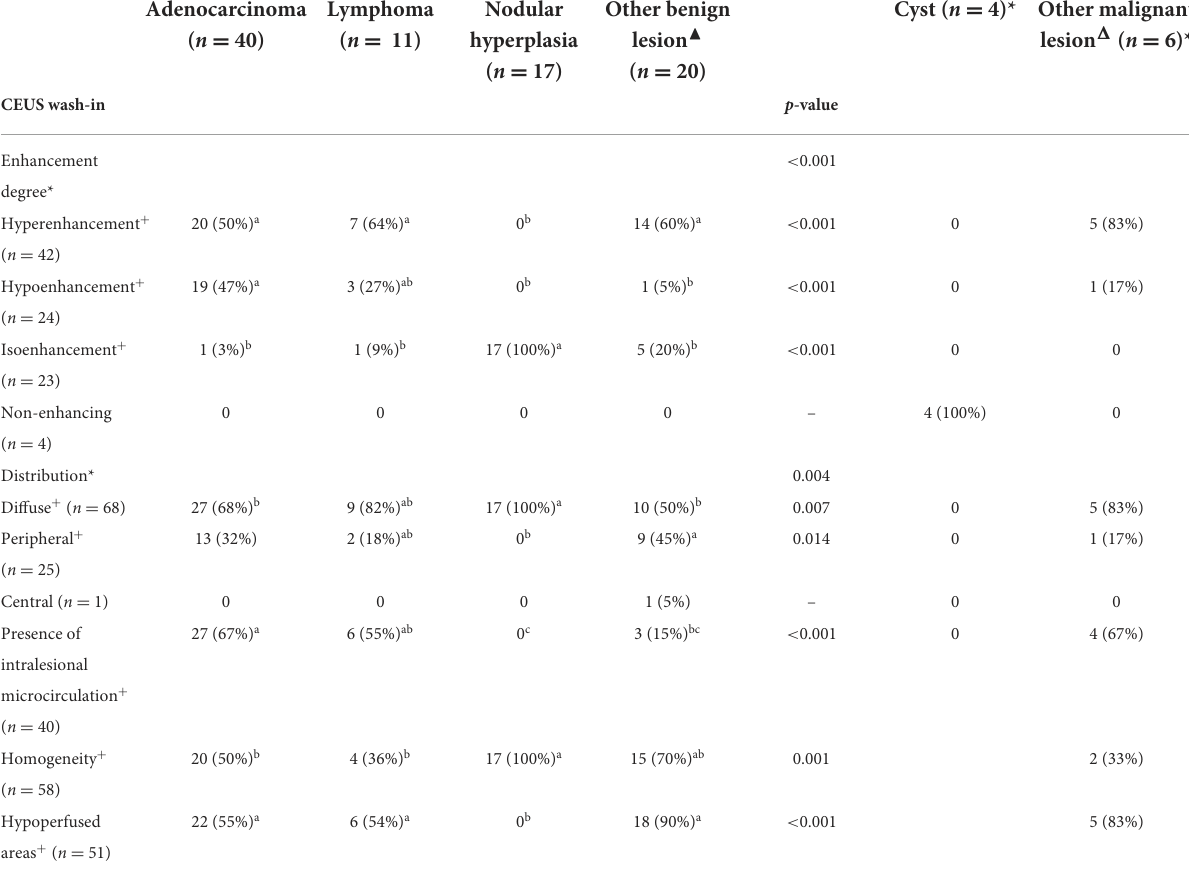
TABLE 2 Qualitative CEUS wash-in features of the lesions, along with cytopathological classification.